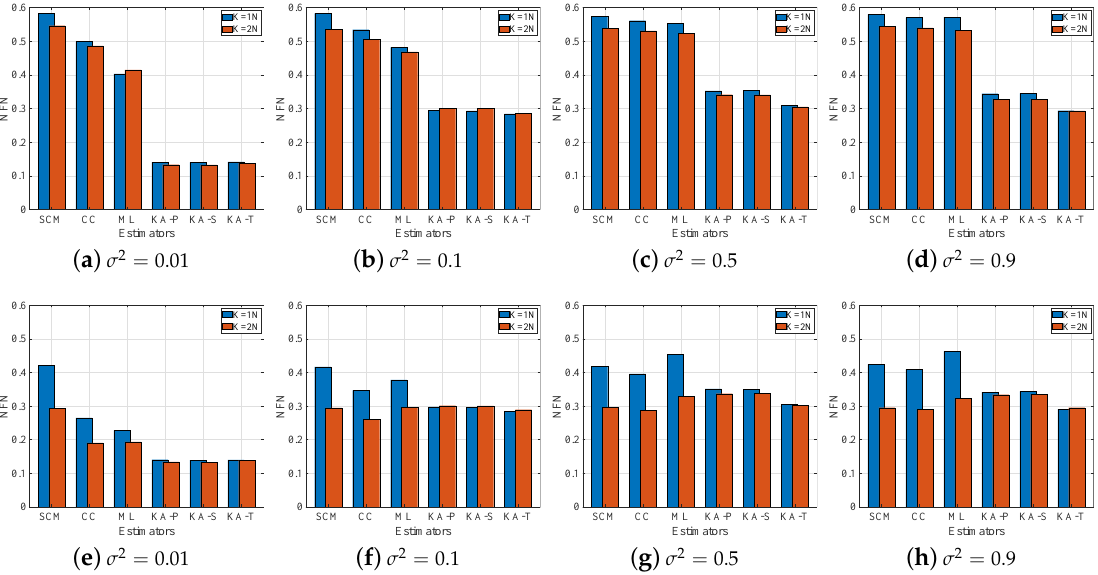
Figure 1. Estimation values of α under different values of the perturbation level clutter, ( a , b ) in compound-Gaussian clutter; ( c , d ) in Gaussian clutter.